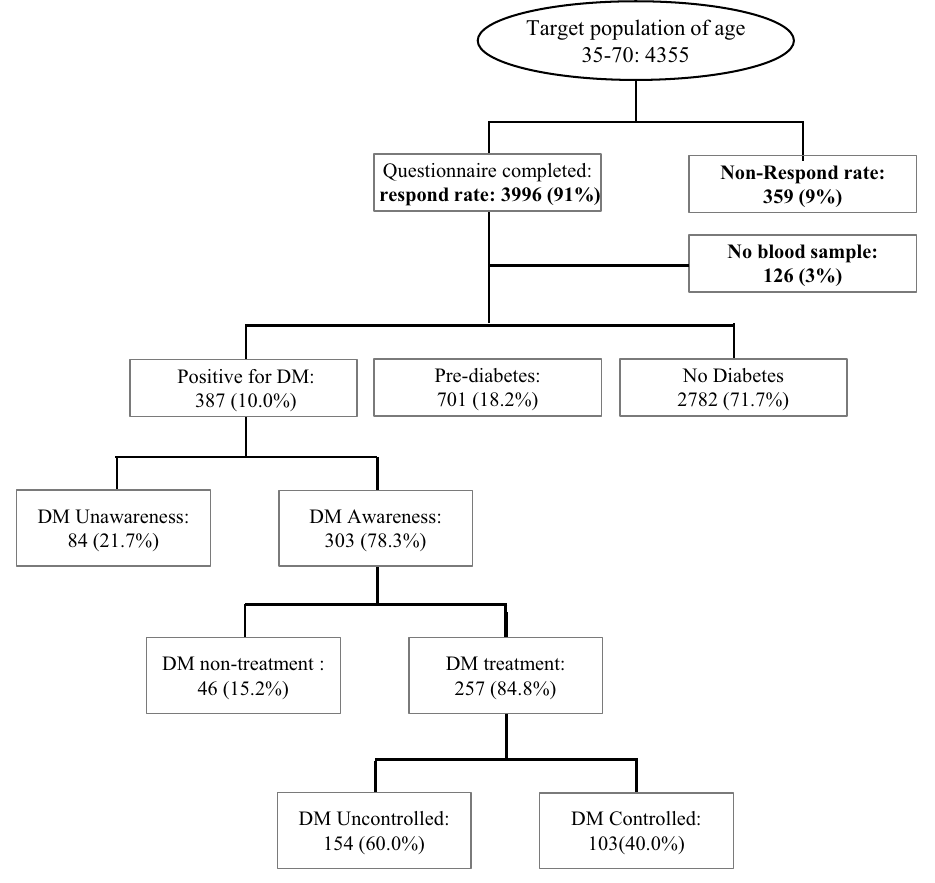
Figure 1. Flow diagram of participants in Dehgolan Prospective Cohort Study (DehPCS), 2018–2019, who respond to questionnaires and agreed for fasting blood glucose